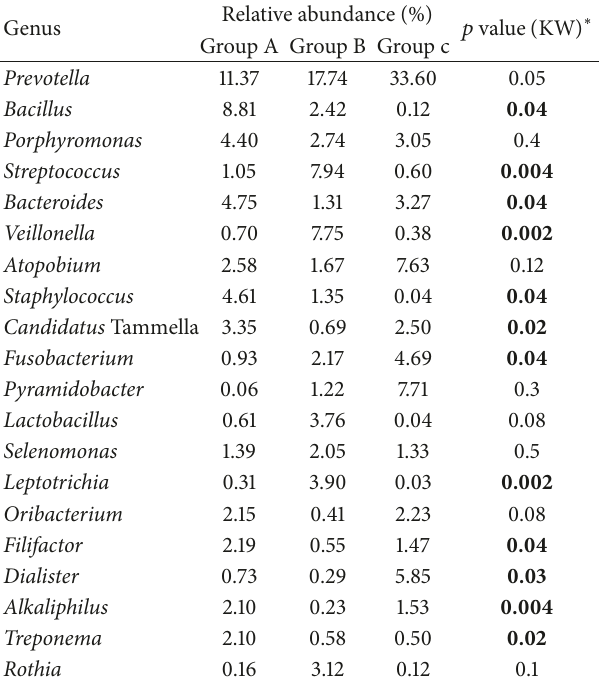
Figure 7: Venn diagram illustrated the number of shared OTUs between males and females at 97% similarity. Colored circles rep- resented each sex and intersection part between circles represented the number of shared